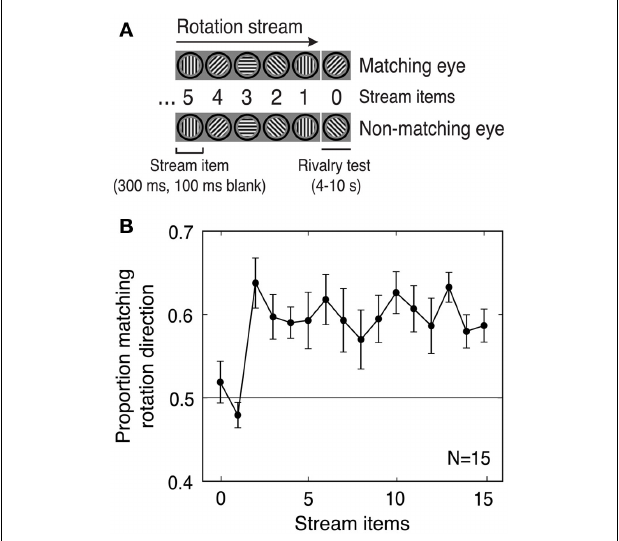
FIGURE 1 | Experiment 1: Predictive context in a pre-rivalry rotation stream influences initial perceptual selection in binocular rivalry. (A) Schematic of the stimuli (pre-rivalry stream and rivalry test).This example stream has clockwise rotation and five stream items shown. Stream items were always presented identically to both eyes, and rivalry items were always a pair of gratings with orthogonal ± 45˚ orientations, with one of the two gratings matching the rotation direction (i.e., it was the expected next item in the rotation stream). (B) Subjects initially perceived the rivalrous grating that matched the rotation direction more often than they initially perceived the non-matching grating whenever the number of stream items was sufficient to define a rotation direction (two or more stream items).The size of this effect was similar for all stream durations from 2 to 15 items. Error bars are